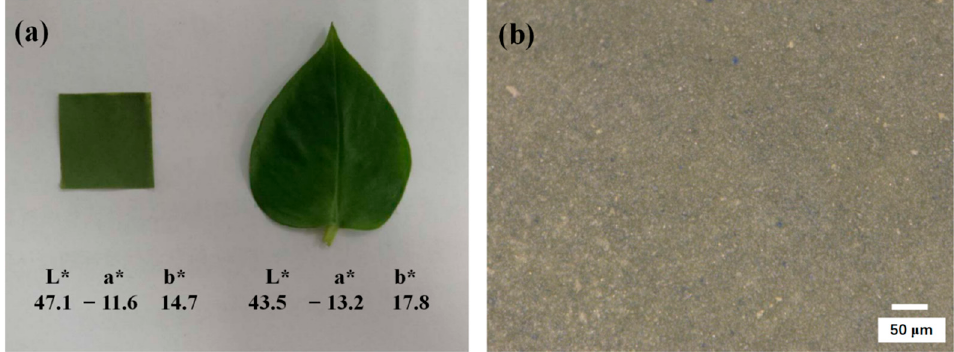
Figure 9. ( a ) Photograph and colorimetric parameters ( L*, a*, b* ) of bionic film and Scindapsus aureus leaf (thickness = 146 μ m) and ( b ) micrograph of the bionic film.